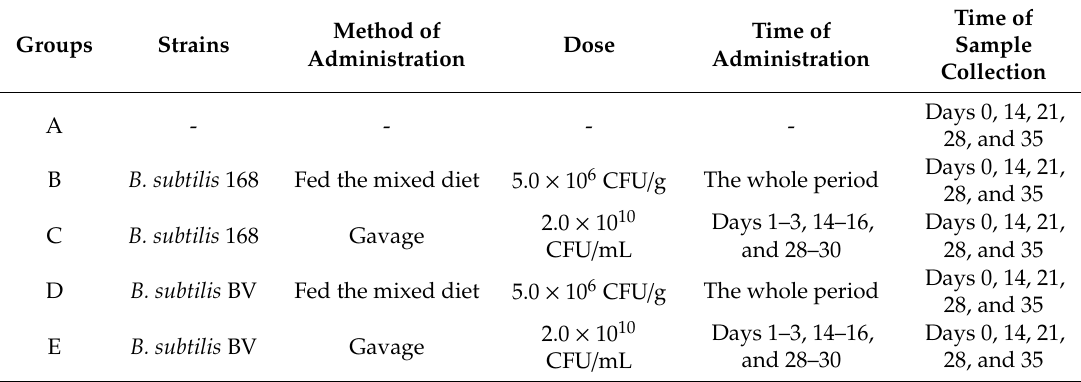
Table 4. Program for the vaccination experiment and time of sample